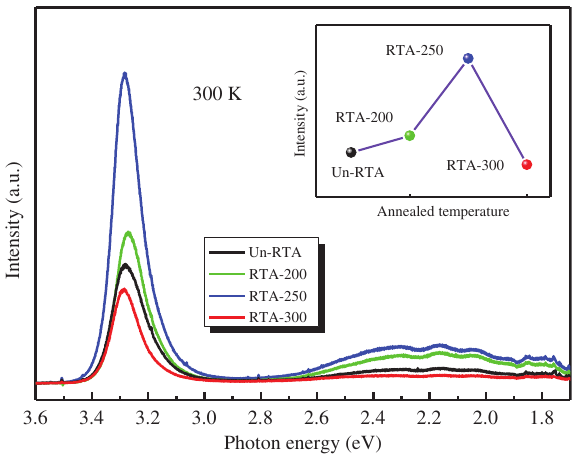
Figure 3: Room temperature PL spectra of Un-RTA, RTA-200, RTA- 250, and RTA-300 samples. The inset is the peak intensity of the UV emission for different